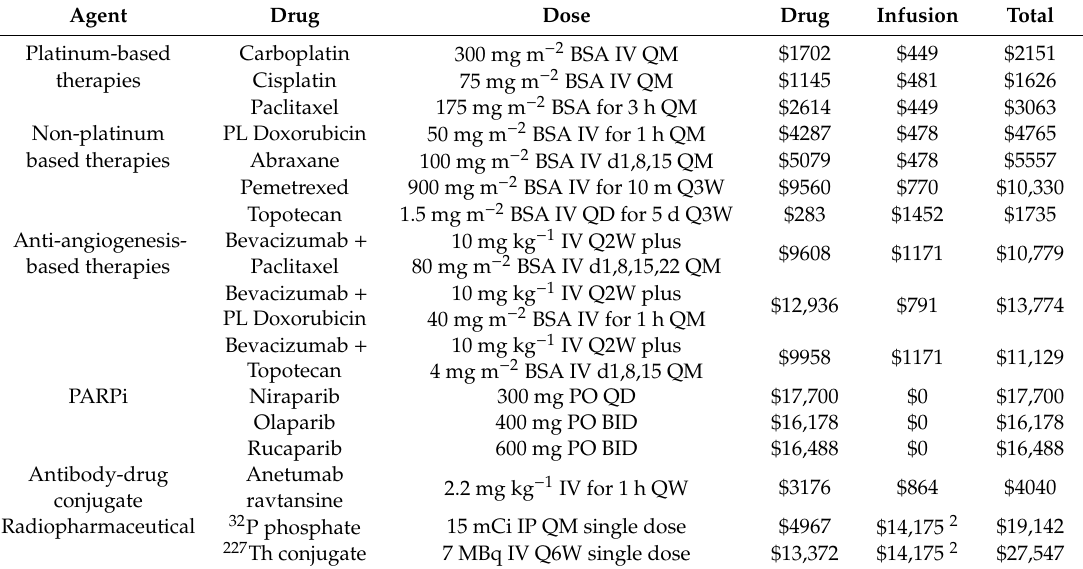
Table 1. Estimated costs for select drugs or radiopharmaceuticals used to treat ovarian carcinoma, per cycle 1